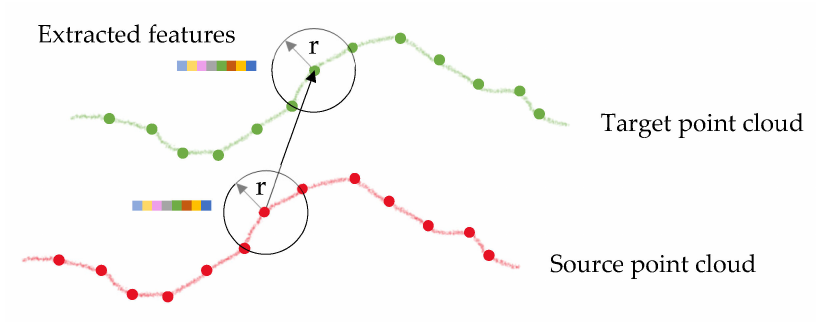
Figure 6. Correspondence between points at different epochs in features